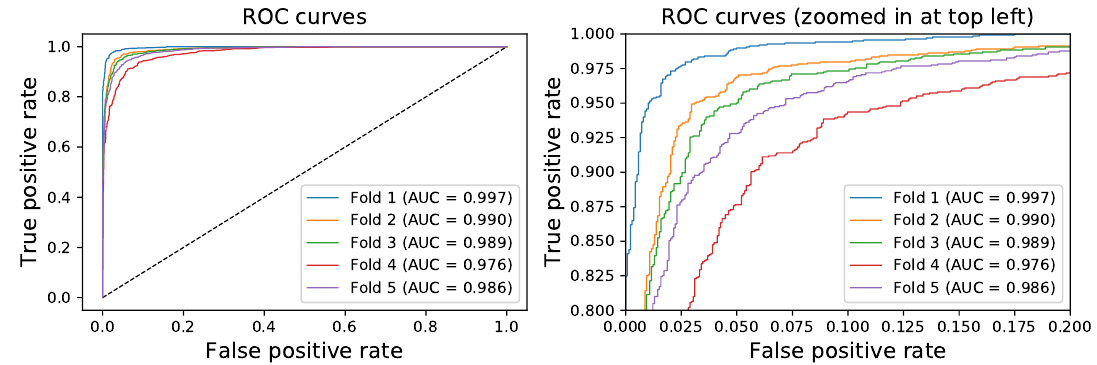
Figure 3. ( Left ): ROC curve for each cross-validation set. ( Right ): zoomed in at top left. AUC values are shown in the